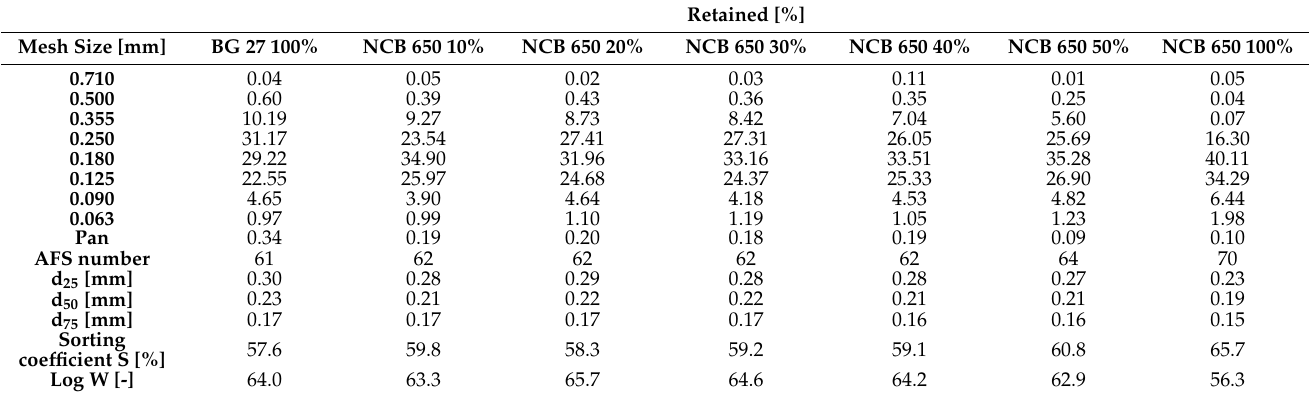
Table 2. Particle size distribution and basic parameters of test sand specimens for NCB 650.